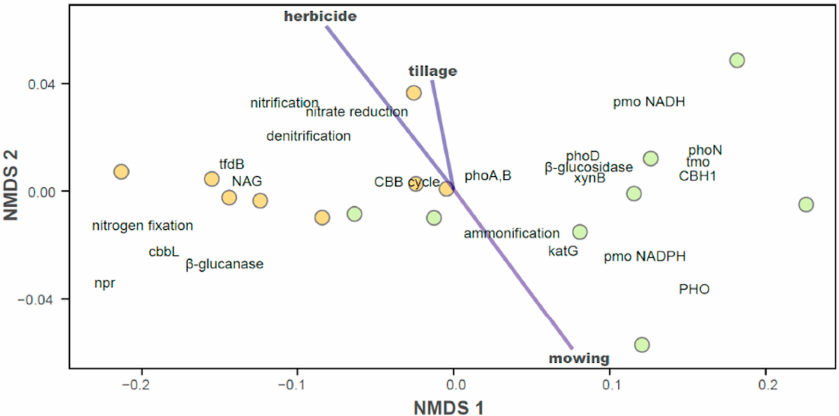
Figure 9. NMDS plot showing mean position of each bacterial KEGG KO according to cover management practices (herbicide, tillage, mowing) as dissimilarity vectors. Each point represents a vineyard sample: conventional (yellow) and organic (green) management. Vector significance: herbicide R 2 = 0.636, p -value = 0.001; tillage R 2 = 0.430, p -value = 0.018; mowing R 2 = 0.636, p -value = 0.001. Management (conventional, organic) significance: R 2 = 0.577, p -value = 0.001. Stress = 0.006.